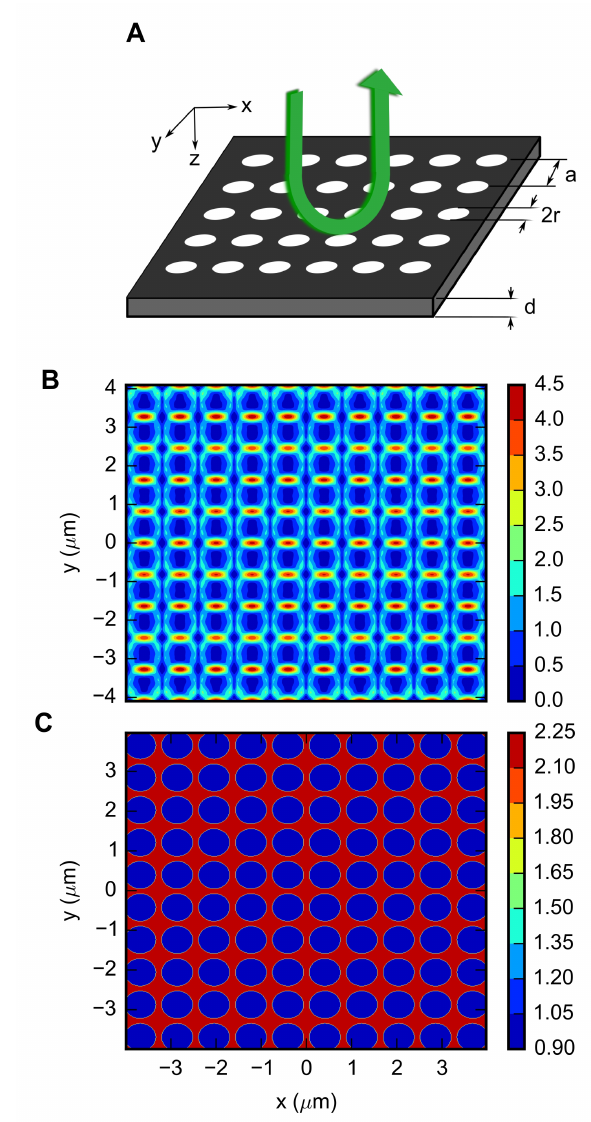
Fig. 9. (A) A photonic crystal membrane which may act as a highly reflecting mirror at particular wavelengths at perpendicular inci- dence to the plane of the membrane. (B) The electric field profile at resonance within the photonic crystal slab is shown. The trapped light occurs as guided modes and guided resonances, the latter of which can cause for 100% reflectivities. (C) Index profile of the plane of the photonic crystal slab. The PC membrane has a thick- ness of 500 nm, lattice constant of 817 nm, and a hole radius of 347